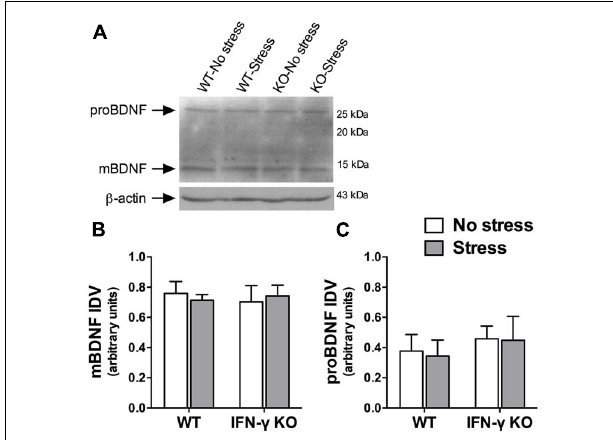
FIGURE 6 | Influence of chronic stress and IFN- γ knockout on BDNF protein expression within the hippocampus. Representative immunoblots (A) were cropped and adjusted for brightness and contrast using Fotor photo editor software (version 1.3.1). Neither chronic stress nor IFN- γ knockout significantly affected mature BDNF (B) or proBDNF (C) protein expression within the hippocampus. Actin-normalized integrated density values (IDVs) are presented as mean ± SEM ( n =